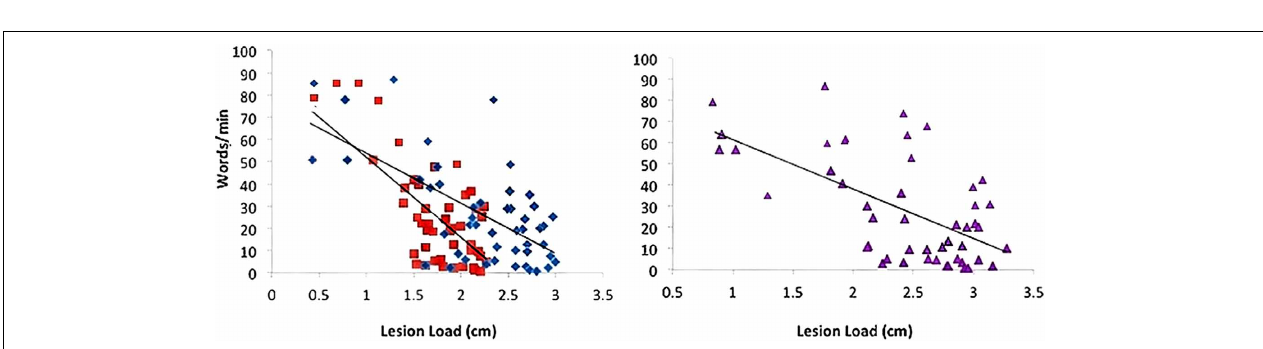
AF-fGM-LL is shown in purple with corresponding regression curves. All regressions are significant ( p < 0 . 01), and AF-LL significantly predicted better for speech efficiency through multiple regression analysis ( p < 0 . 01).